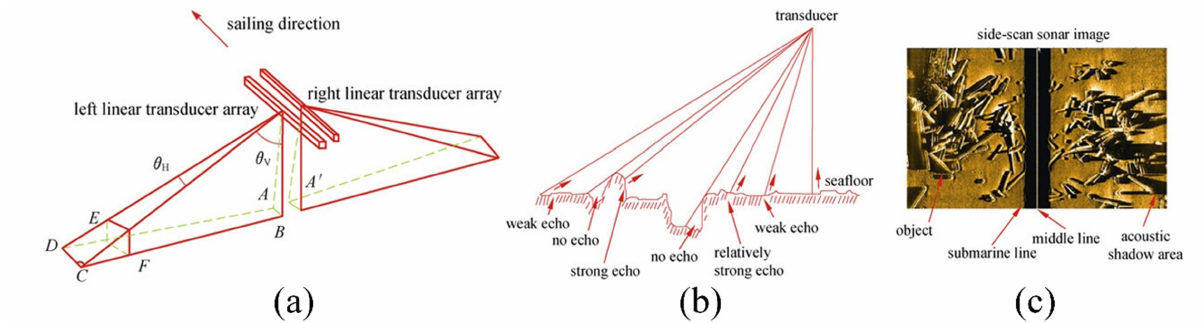
Figure 2. ( a , b ) Side-scan sonar working principle. ( c ) Principle of side-scan sonar image generation [21].